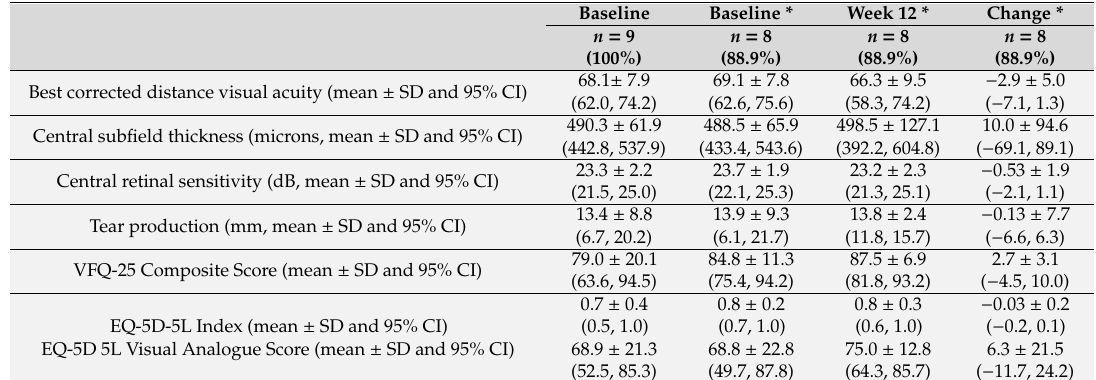
Table 3. Descriptive statistics for outcome measures at baseline and at week 12.